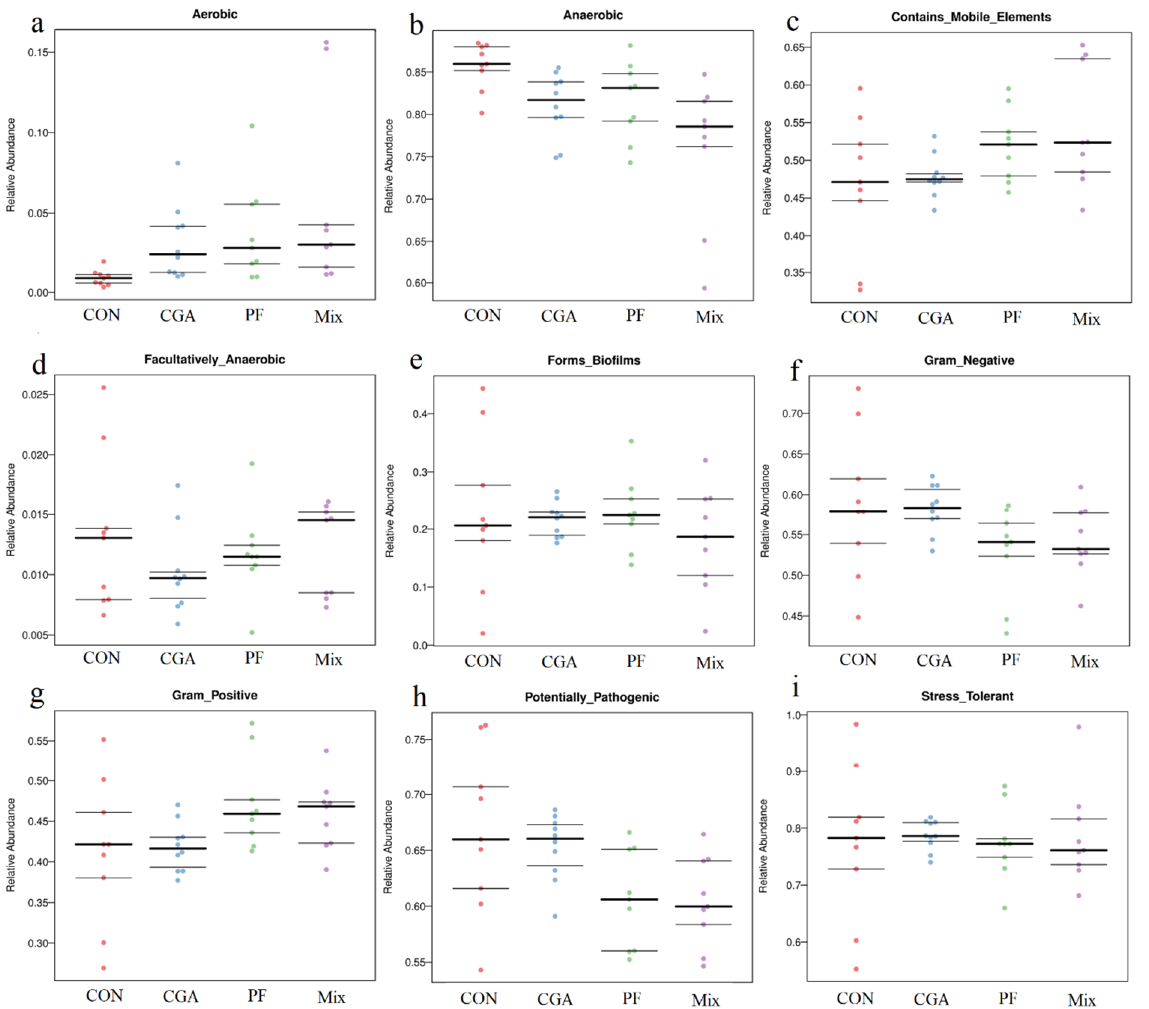
Figure 10. Prediction of BugBase phenotypes. The horizontal coordinate in the figure is the group name, the vertical coordinate is the relative abundance (%), and the three lines from bottom to top are the lower quartile, the mean, and the upper quartile, respectively, showing nine phenotypes: ( a ) aerobic, ( b ) anaerobic, ( c ) contains mobile elements, ( d ) facultatively anaerobic, ( e ) biofilms forms, ( f ) Gram-negative, ( g ) Gram-positive, ( h ) potentially pathogenic, and ( i ) stress tolerant. Table 5. Effect of crude extract of honeysuckle and Pueraria lobata root on the apparent digestibility of nutrients in finishing